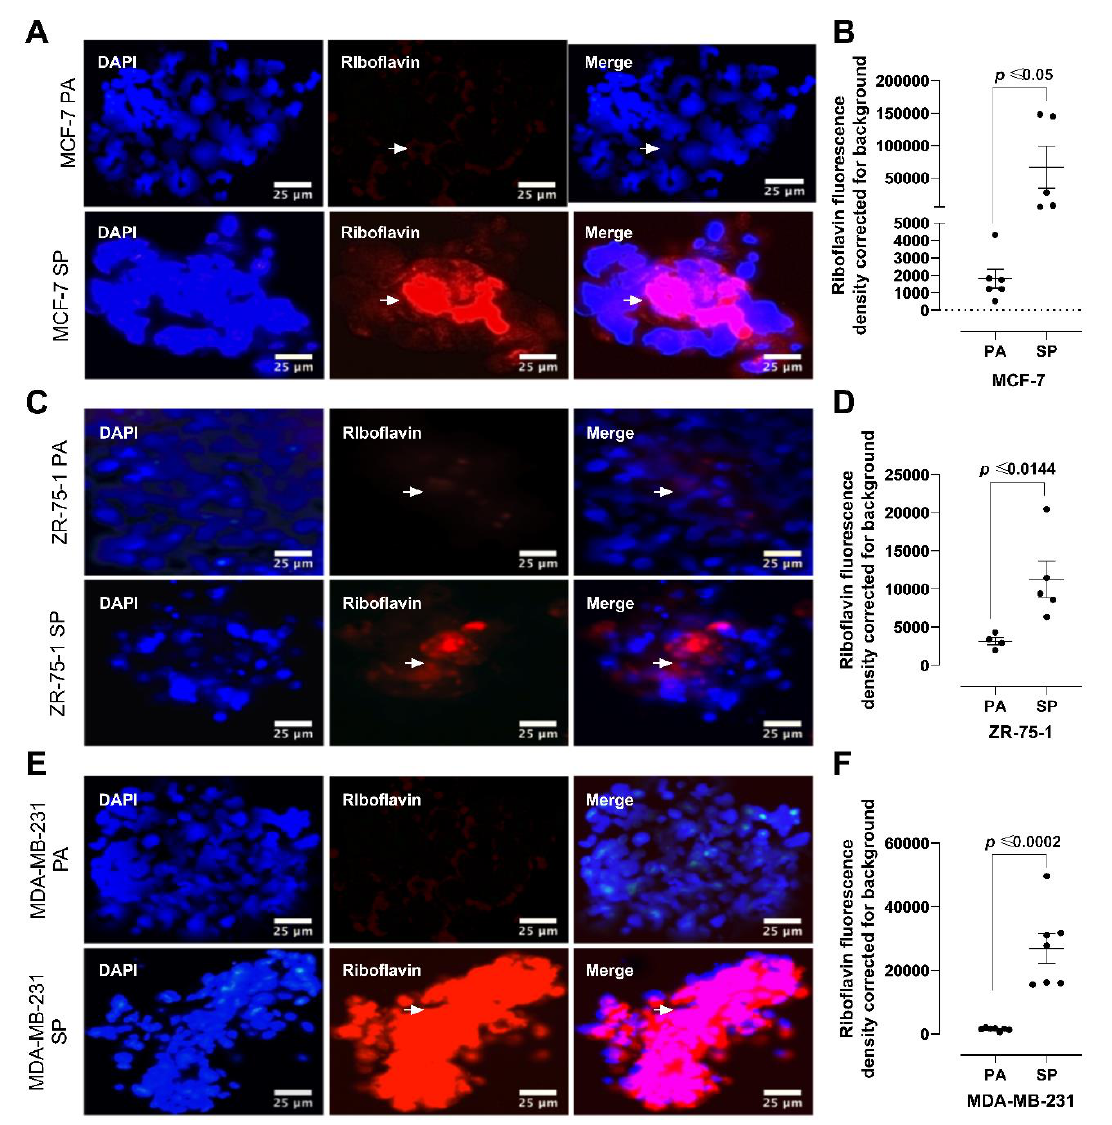
Figure 3. Analyses of 2D monolayer cells and 3D spheroids of MCF-7, ZR-75-1, and MDA-MB- 231 breast cancer cells for riboflavin autofluorescence using epifluorescent microscopy. ( A , B ) MCF-7, ( C , D ) ZR-75-1, and ( E , F ) MDA-MB-231 breast cancer cells cultured as monolayers (PA) and 3rd generation spheroids (SP) were compared for the uptake of riboflavin as detected by autofluorescence ( λ ex/ λ em 540 nm/570 nm). Breast cancer PA and SP were incubated with riboflavin (1:50) for 1 h and mounted in PBS/glycerol (1:1). Cells were counterstained with DAPI to visualize the nuclei. Coverslips were examined by epifluorescence microscopy ( λ ex/ λ em = 450/525 nm; scale bar = 25 µ m). The results are depicted as a scatter plot, where dots represent the indicated marker values of cells obtained from the representative of 3 independent experiments of multiple cell images ( n = 7–8). The mean fluorescence density staining corrected for background ± SEM for indicated marker values is indicated for each group. The density staining riboflavin values of each SP group were compared to the PA group using the unpaired two-tailed t -test comparisons with 95% confidence. Abbreviations: PA, parental; SP, spheroid; PBS, phosphate-buffered saline; DAPI, 4′,6-Diamidine-2′-phenylindole dihydrochloride.